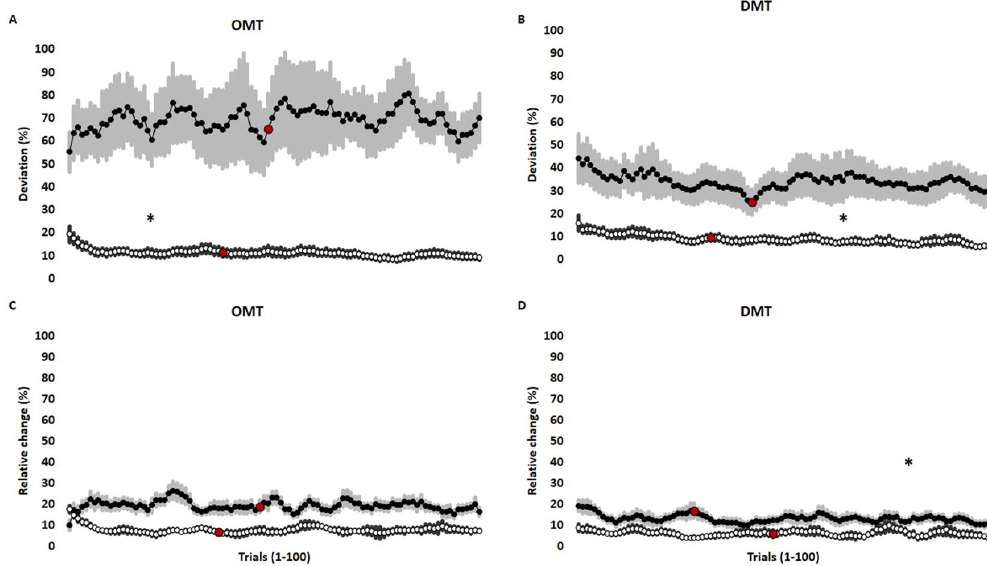
Figure 4. Mean and standard error of mean representing the dynamics of accuracy ( A , B ) and precision ( C , D ) of controlled forces during OMT ( A , C ) and DMT ( B , D ) with low hold force (black circles) and high hold force (white circles). The data represents the average of the one hundred trials from eighteen participants across each session. A stepwise/segmented linear regression analysis was done to study the dynamic changes. The two slopes (viz. initial stage and final stage) of the regression lines were obtained from each participant during each session and the two slopes were compared to a horizontal line. The intersection of the two slope are demarcated by red circles. The asterisk ( * ) denote significant differences between the high hold force slope and the horizontal